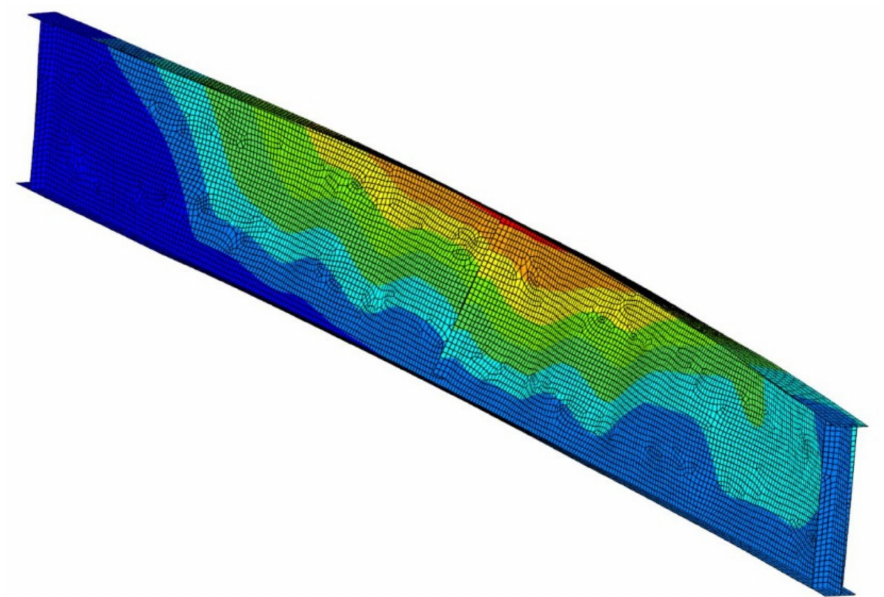
Figure 18. Failure mode—beam B1, scale ×